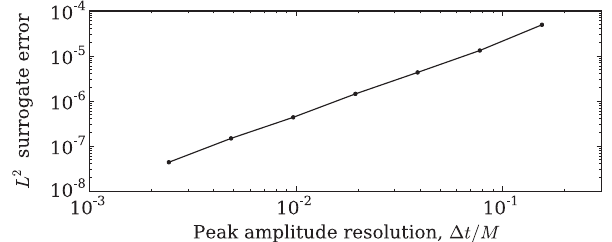
FIG. 15. The dependence of the error (31) when using the surrogate to model an EOB waveform (with q ¼ 1 . 068 from Fig. 9) as a function of the resolution (i.e., time steps) of the peak amplitude. The trend is linear in Δ t=M . The resolution leads to an uncertainty in estimating the peak amplitudes and thus in aligning the waveforms. This is the dominant source of error in the surrogate model that translates directly into errors in the fits of the last offline step for building the